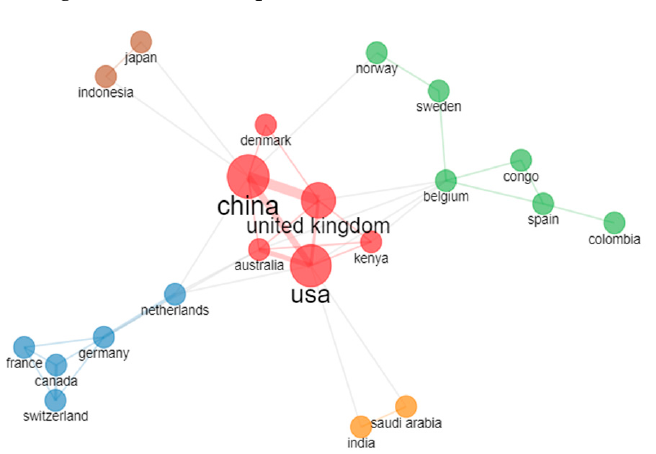
Figure 2. Partnerships between countries. (Elaborated through the Bibliometrix software).